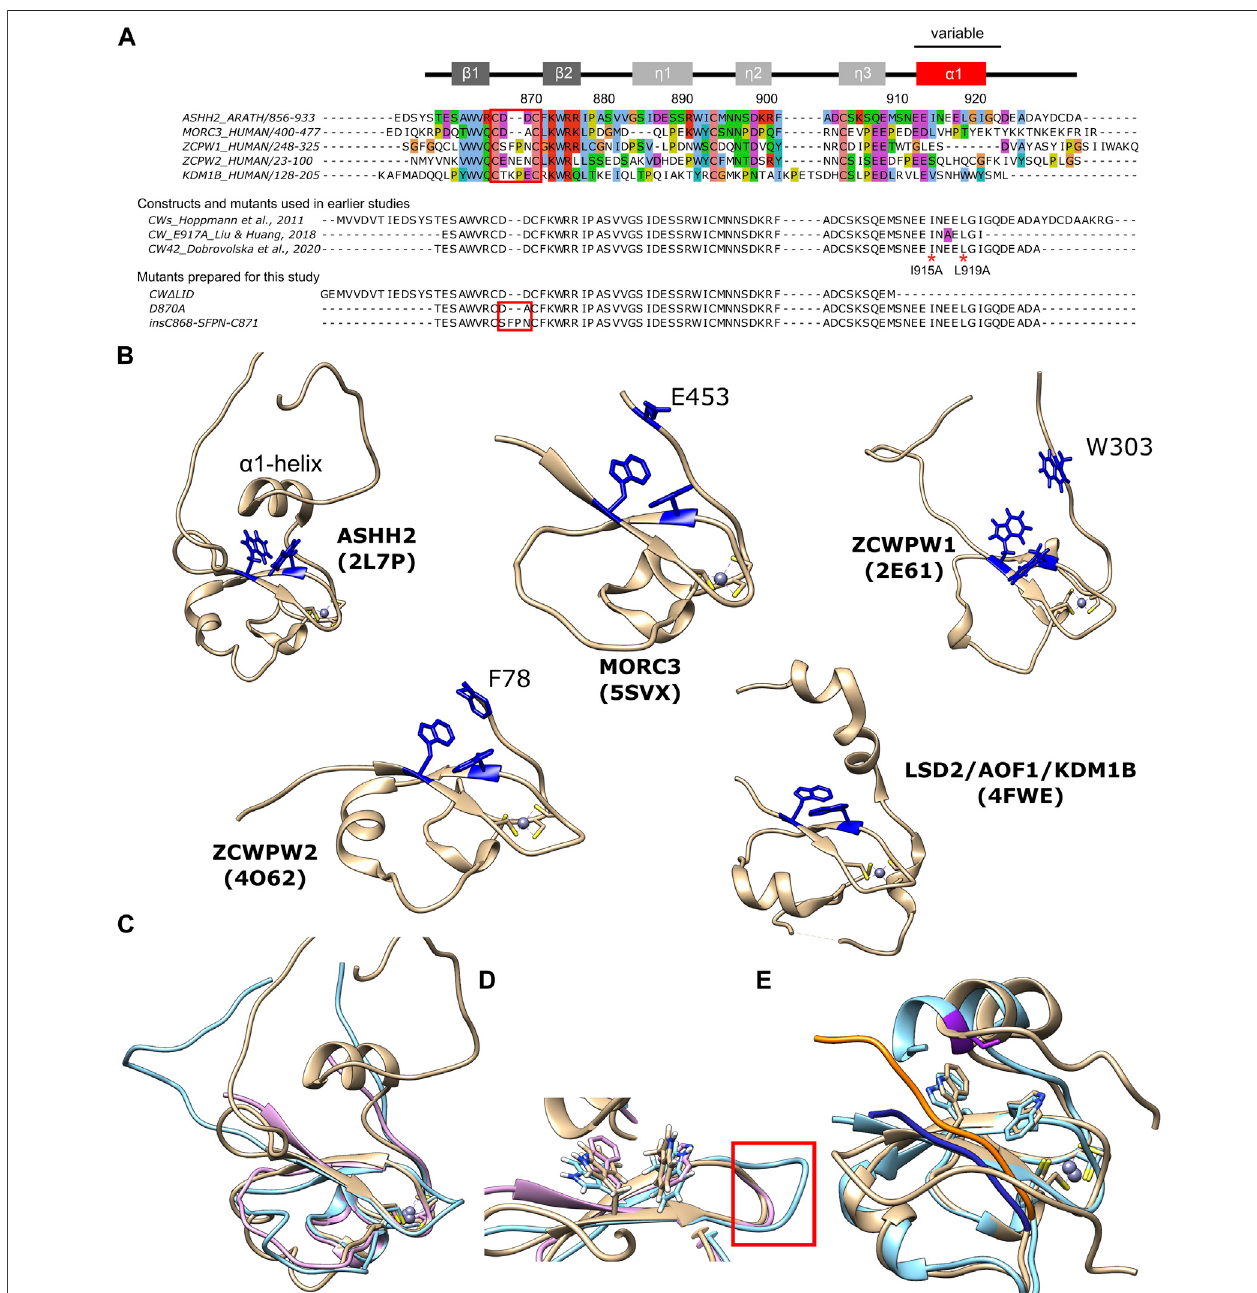
FIGURE 1 | Overview of CW domains and structural analysis. (A) TOP: sequence alignment of CW domains of ASHH2 methyltransferase ( Arabidopsis thaliana , Q2LAE1), MORC3 protein ( Homo sapiens , Q14149), ZCWPW1 protein ( Homo sapiens , Q9H0M4), ZCWPW2 protein ( Homo sapiens , Q504Y3), and KDM1B histone demethylase ( Homo sapiens , Q08EI0). The alignment was prepared using Jalview software and UniProt entries with ClustalO default parameters, and Clustalx coloring scheme was used. MIDDLE: CW domain constructs used in earlier studies on the ASHH2 CW domain by Hoppmann et al. (2011), Liu and Huang (2018), and Dobrovolska et al. (2020). The E917A mutation used by Liu and Huang (2018) is marked by purple color. I915A and L919A mutations were analyzed by Liu and Huang (2018) and inthisworkaremarkedbyred *symbols.BOTTOM:sequencesoftheadditional mutants(CW Δ LID,D870A,andinsC868-SFPN-C871)prepared exclusively forthiswork.Thesecondary structure ofCWisindicatedatthetopofthepanel. Theredsquares indicate thevariableloopsituatedbetweenthe β -strandsthatformpart ofthebindingsite.TheseconstructsalsohaveanN-terminalsequence( “ GSRRASVGSEF ” )thatisnotshowninthe fi gure; (B) overviewofCWdomainstructures:ASHH2 ( 2L7P ), MORC3 ( 5SXV ), ZCWPW1 ( 2E61 ), ZCWPW2 ( 4O62 ), and LSD2/AOF1/KDM1B ( 4FWE ) (tryptophans forming binding pockets and the variable C-terminal region residues, implicated in binding, are highlighted in blue); (C) superposition of CW domain structures: ASHH2 (brown), MORC3 (pink), and ZCWPW1 (blue); (D) close-up view of the binding pocket. The loops between the β -strands subject to the insC868-SFPN-C871 mutation are indicated by red square; and (E) overlay of CW